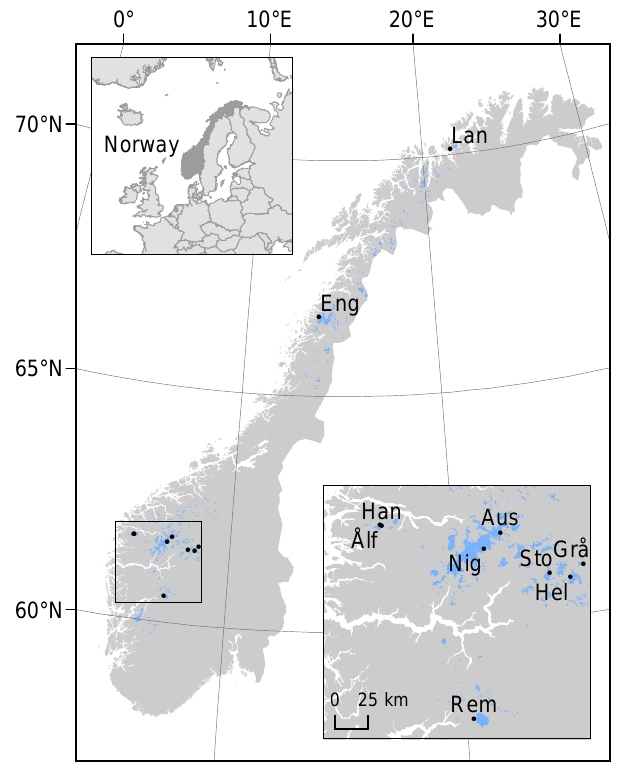
Figure 1. Location map of Norway showing the 10 study glaciers with long-term glaciological mass-balance series. Glaciers are shaded in blue. See Table 1 for details on the glaciers. The inset shows Norway’s location in Europe and a zoom in on the eight glaciers in southern